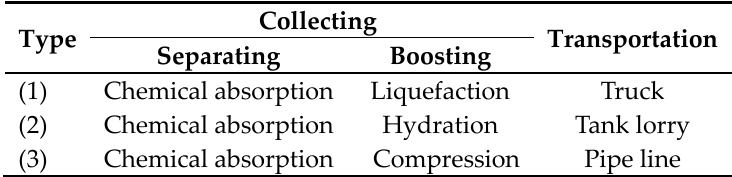
Table 1. Some CO 2 supply